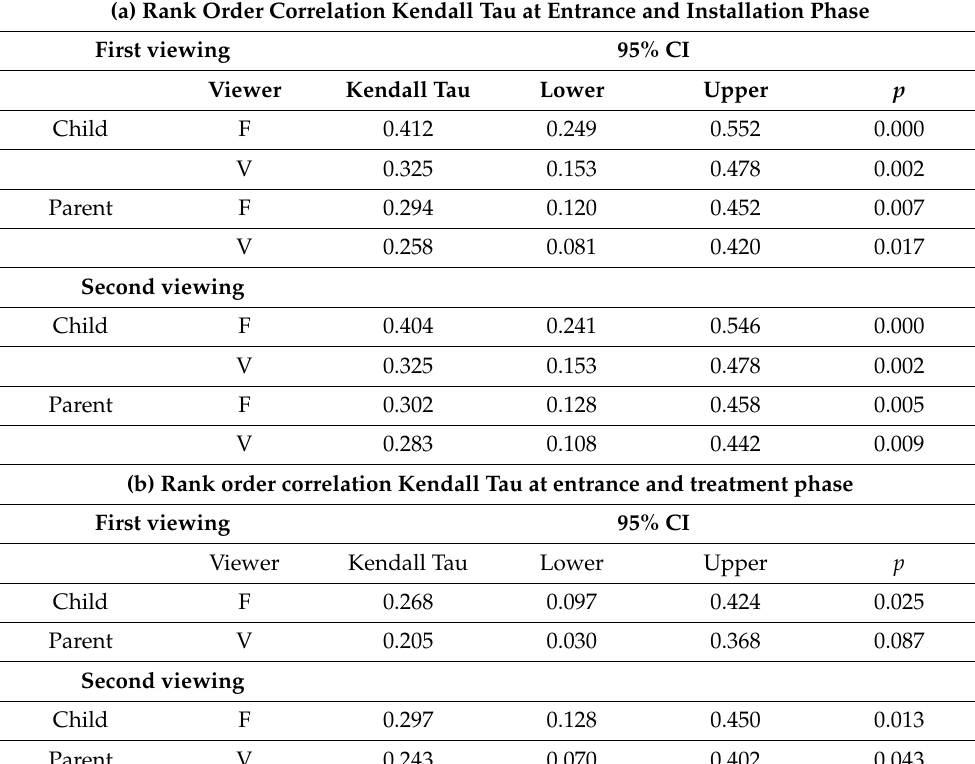
Table 5. Rank-order correlation Kendall Tau. (a). Between the raw MDAS scores and the parental hetero-assessment scale (Parent) and the modified Venham scale (Child) averaged for the entrance and installation phases for the two viewers (F and V) and the consecutive views ( n = 54). (b). Between the parental hetero-assessment scale (Parent) upon entrance and the modified Venham scale (Child) at treatment ( n = 57) for the two viewers (F and